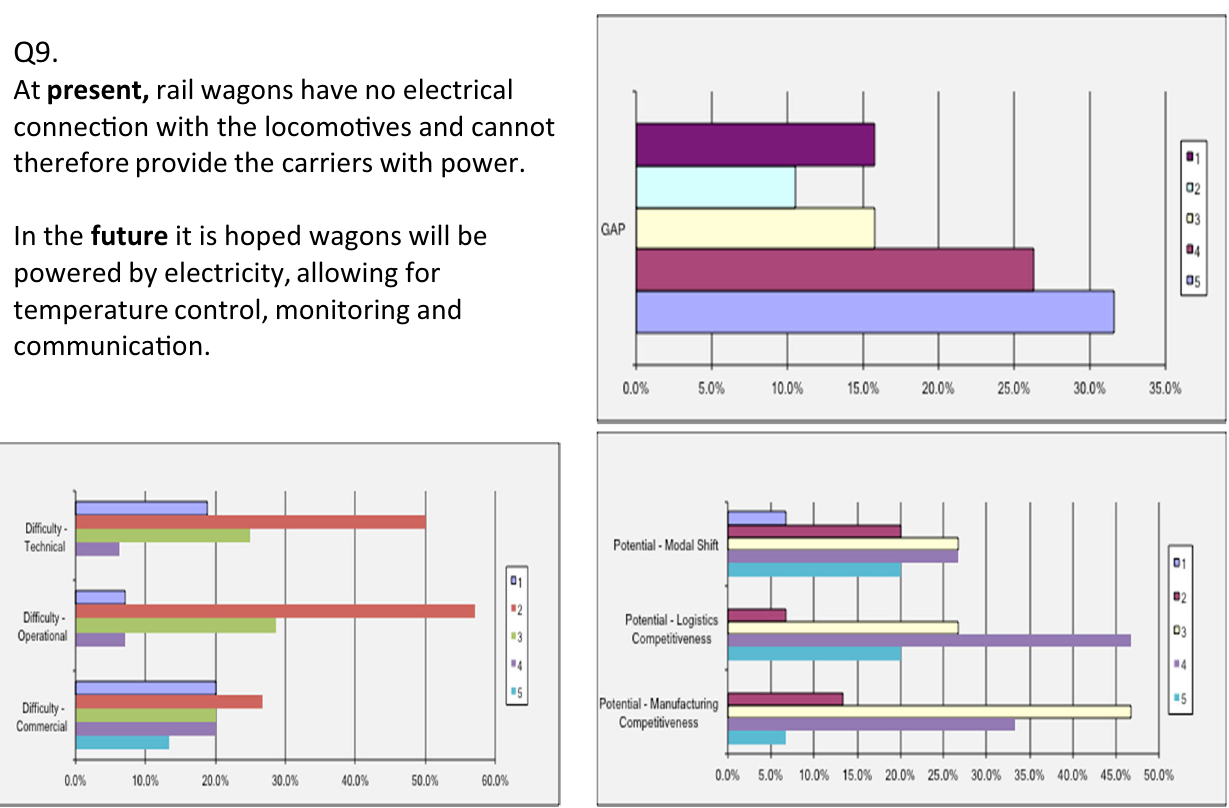
Fig. 1 Provision of electrical power supply to individual